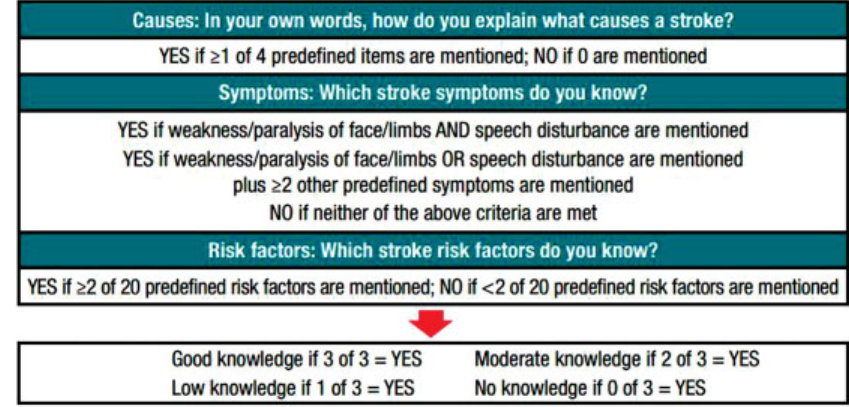
Fig. 1 Scoring system to categorize patients ’ level of stroke knowledge (from open-ended